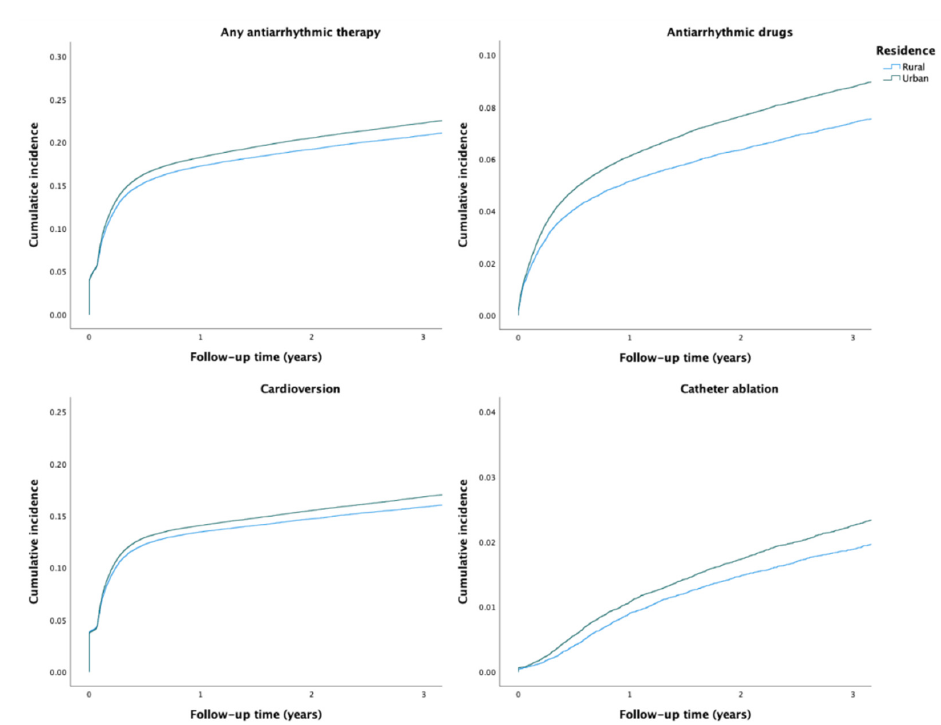
Figure 1. Crude cumulative incidence curves of the use of AATs.